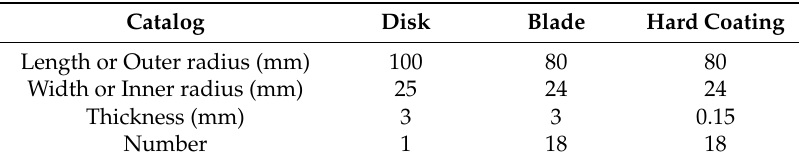
Table 2. Material parameters of the blisk with hard ‐ coated blades.